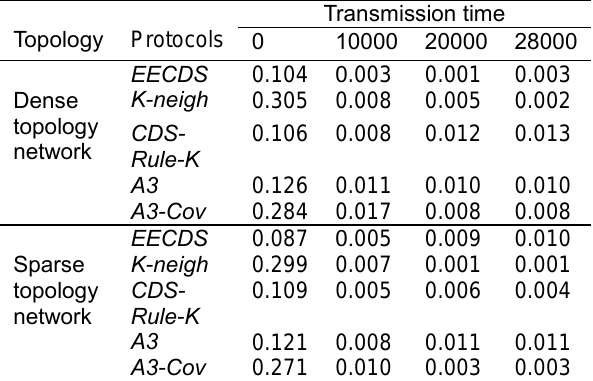
Table 8 Experiment 4: Covered area for